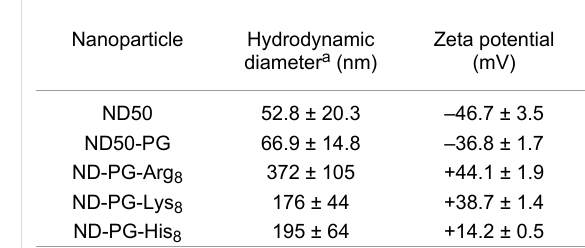
Table 1: Hydrodynamic diameter and zeta potential of nanoparticles in Milli-Q